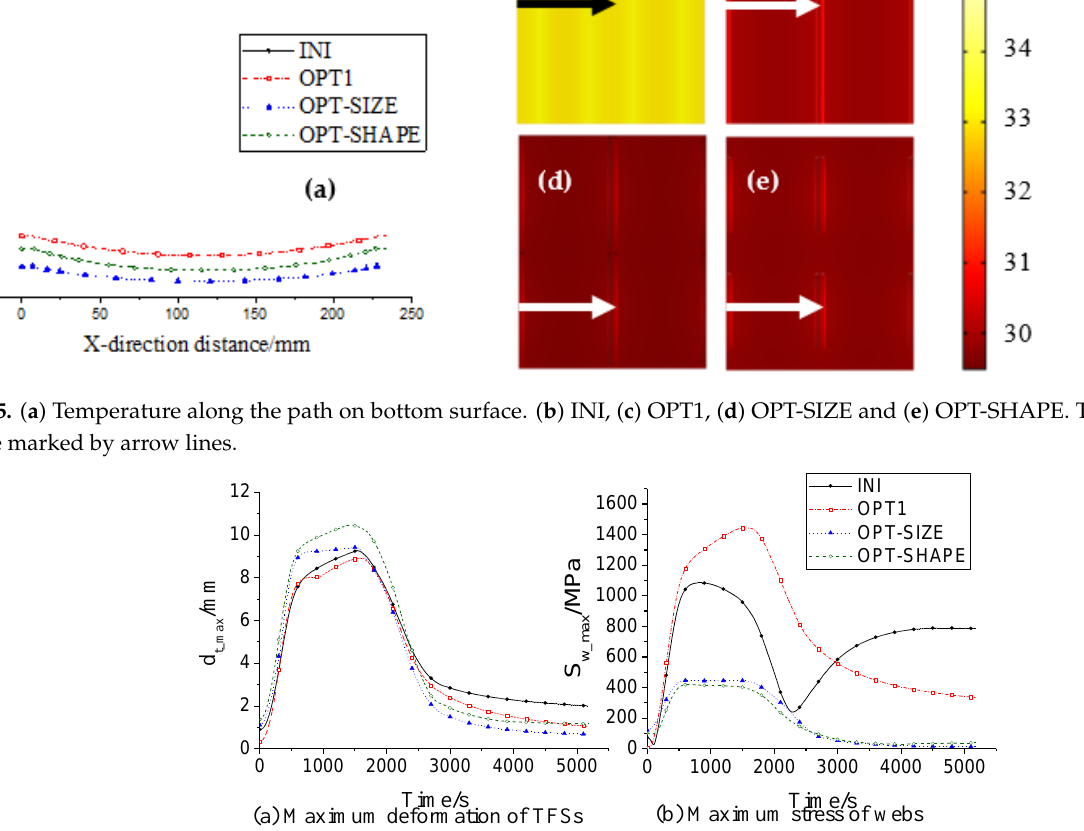
Figure 16. Mechanical responses of the initial and optimized designs.